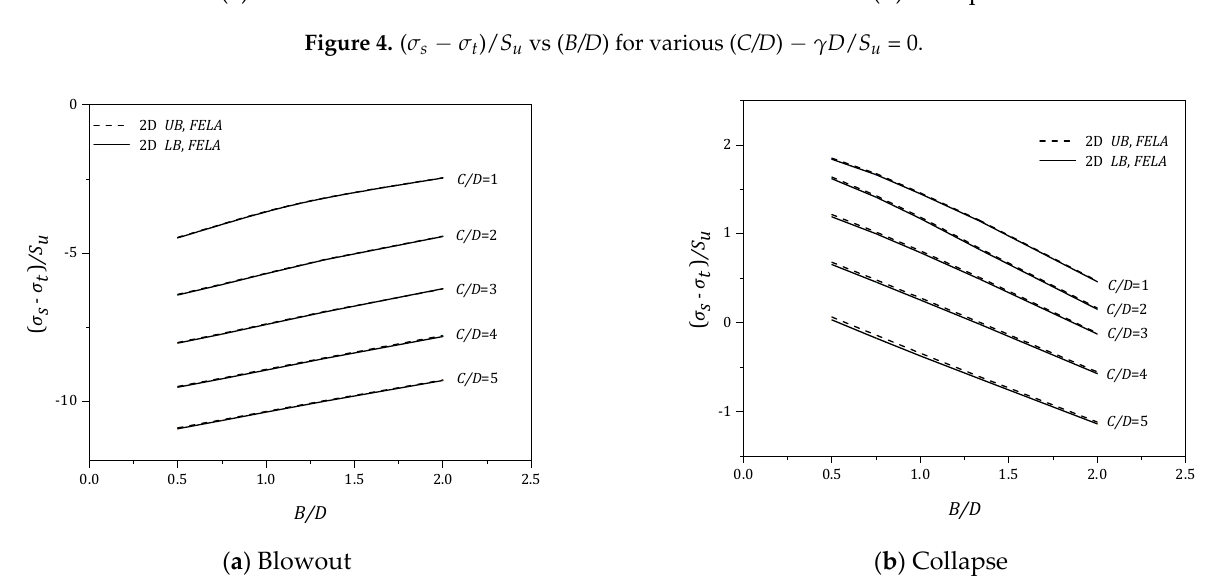
Figure 5. ( σ s − σ t )/ S u vs ( B/D ) for various ( C/D ) − γ D / S u = 1.